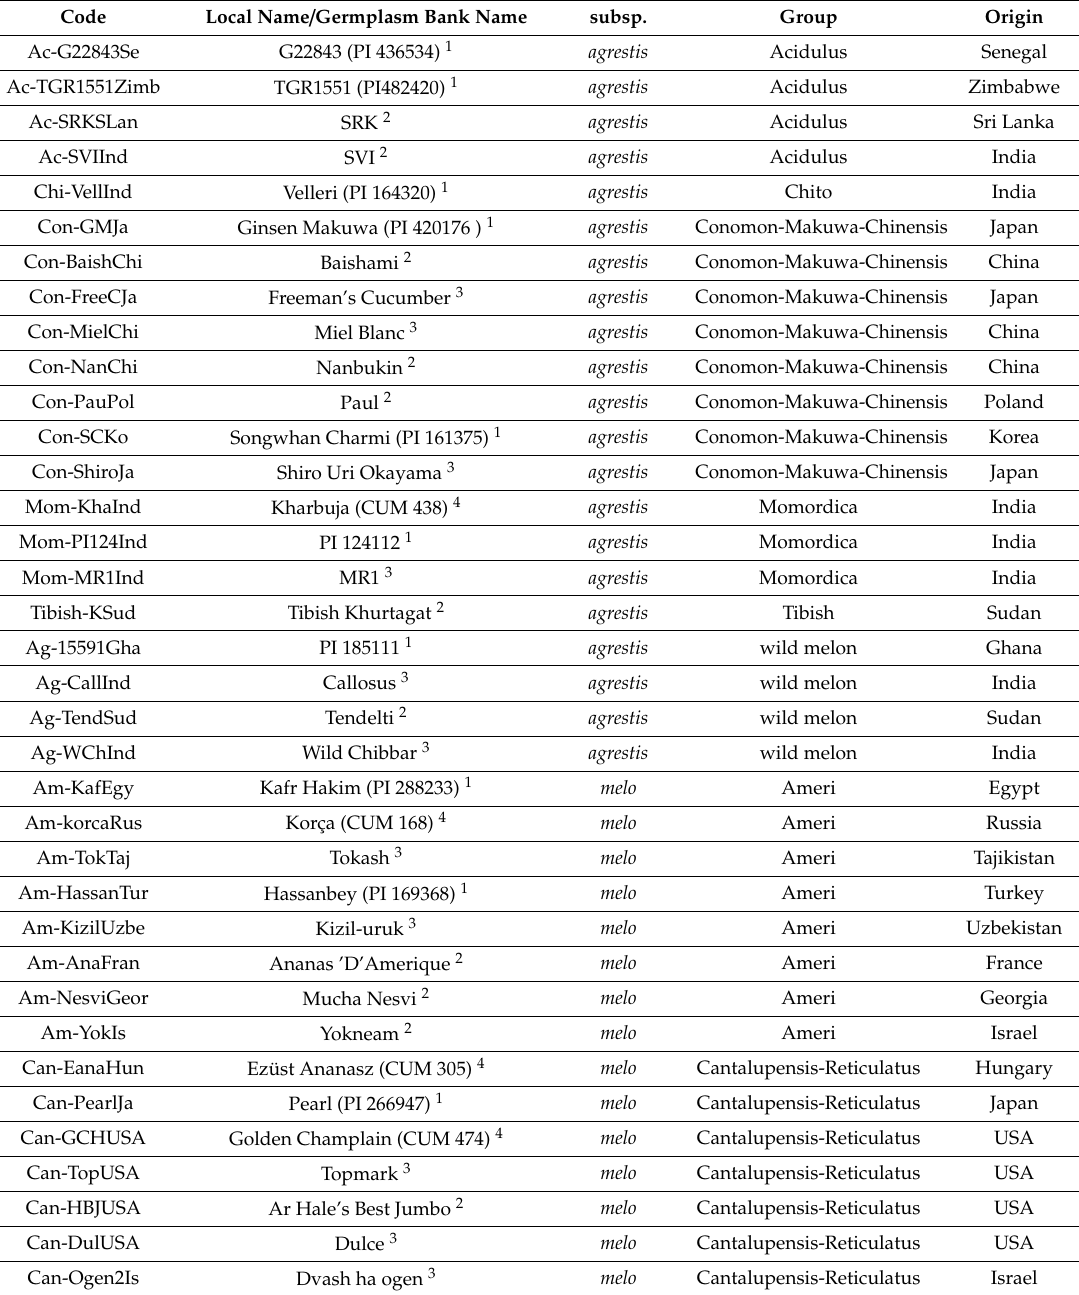
Table 1. Accessions assayed for rind volatile